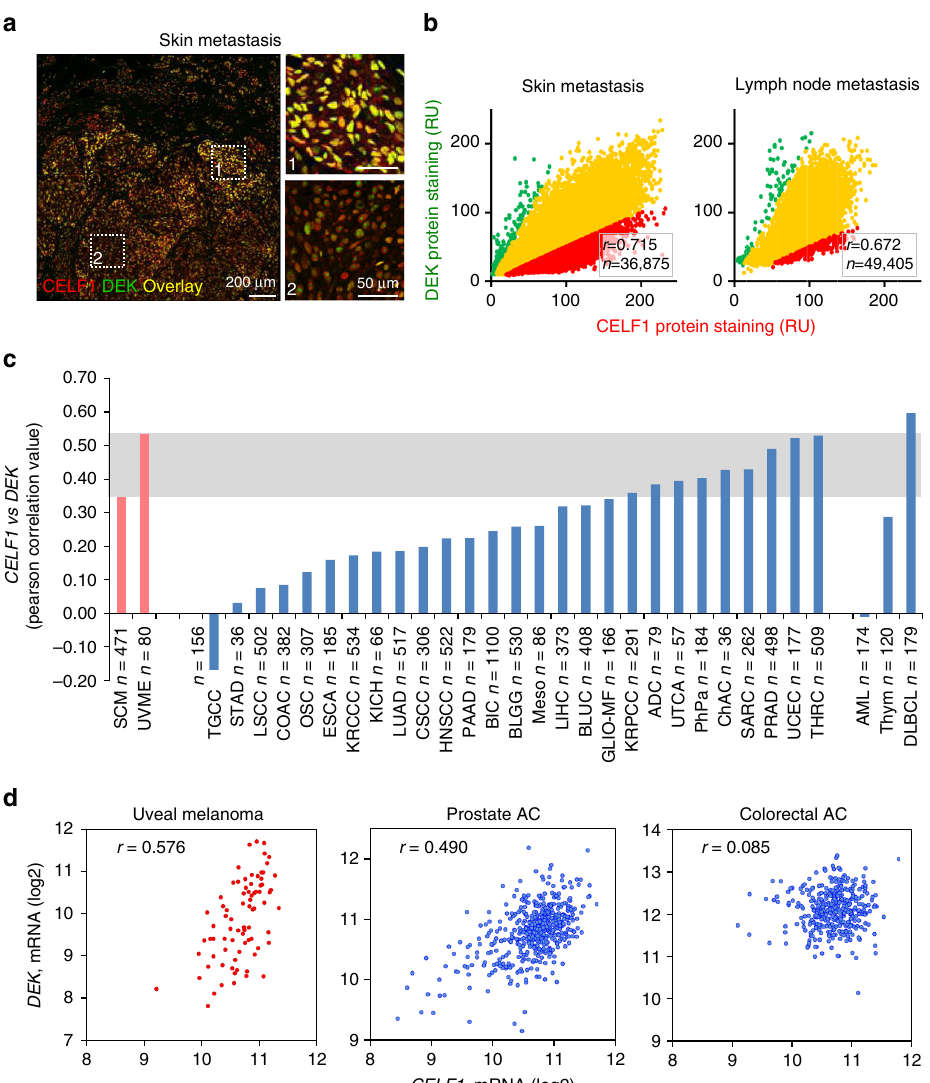
Fig. 7 DEK expression correlates with CELF1 expression in vivo. a Single-cell quanti fi cation analysis of CELF1 (red) and DEK (green) protein expression by confocal microscopy in a representative skin metastasis of human melanoma. Images on the right show higher magni fi cation of selected areas of the lesion with high or low expression of both proteins (insets 1 and 2, respectively). b Quanti fi cation of nuclear staining of CELF1 and DEK in skin and lymph node melanoma metastasis human biopsies, respectively. Relative nuclear staining of CELF1 and DEK plotted in a maximum range of RGB color scale (0 – 255). Data points were pseudo-colored based on red/green signal intensity ratio (red, ratio ≥ 2; green, ratio ≤ 0.5; yellow, 0.5 < ratio < 2). r , Pearson correlation; n , total number of quanti fi ed cells in the whole tissue. c DEK vs. CELF1 mRNA expression in various cancer types plotted as a function of corresponding signi fi cance (Pearson correlation value) ADC adrenocortical carcinoma, AML acute myeloid leukemia, BIC breast invasive carcinoma, BLGG brain lower grade glioma, BLUC bladder urothelial carcinoma, ChAC cholangiocarcinoma, COAC colorectal adenocarcinoma, CSCC cervical squamous cell carcinoma and endocervical adenocarcinoma, ESCA esophageal carcinoma, GLIO-MF glioblastoma multiforme, HNSCC head and neck squamous cell carcinoma, KICH kidney chromophobe, KRCCC kidney renal clear cell carcinoma, KRPCC kidney renal papillary cell carcinoma, LIHC liver hepatocellular carcinoma, LNDLBCL lymphoid neoplasm diffuse large B-cell lymphoma, LSCC lung squamous cell carcinoma, LUAD lung adenocarcinoma, Meso mesothelioma, OSC ovarian serous cystadenocarcinoma, PAAD pancreatic adenocarcinoma, PhPa pheochromocytoma and paraganglioma, PRAD prostate adenocarcinoma, SARC sarcoma, SCM skin cutaneous melanoma, STAD stomach adenocarcinoma, TGCC testicular germ cell cancer, THRC thyroid carcinoma, Thym thymoma, UCEC uterine corpus endometrial carcinoma, UTCA uterine carcinosarcoma, UVME uveal melanoma. n , number of samples. d DEK vs. CELF1 mRNA in uveal melanoma ( n = 80), prostate adenocarcinoma ( n = 498) and colorectal adenocarcinoma ( n = 382) patients (data obtained from TCGA) shown on correlation scatter plots Methods μ g/mL penicillin/streptomycin (Invitrogen). Cell lines have been authenticated Cell culture . The human melanoma cell lines SK-Mel-5, SK-Mel-19, SK-Mel-28, using GenePrint 10 Loci Service. Primary human melanocytes, keratinocytes, and fi broblasts were isolated from foreskins of healthy donors by differential tripsini- SK-Mel-29, SK-Mel-103, and SK-Mel-147 were initially obtained from David zation 20 . Melanocytes were cultured in Medium 254 (Invitrogen) supplemented Polsky from the Memorial Sloan Kettering cell repository. G-361 and UACC-62 with 1% melanocyte growth factors (HMGS, Invitrogen), 0.2mM CaCl 2 , and 100 were from the ATCC. WM-1366 and LU-1205 were provided by Meenhard Her- μ g/mL penicillin/streptomycin; keratinocytes were cultured in Epilife Medium lyn ’ s group at the Wistar Institute (see Supplementary Table 1 for genetic back- (Invitrogen) supplemented with 1% keratinocyte growth factors (HKGS, Invitro- grounds). These cells were cultured in Dulbecco ’ s modi fi ed Eagle ’ s medium gen), 0.2 mM CaCl 2 and 100 μ g/mL penicillin/streptomycin and fi broblasts were (DMEM, Lonza) supplemented with 10% fetal bovine serum (FBS, Lonza) and 100 NATURE COMMUNICATIONS | 8: 2249 | DOI: 10.1038/s41467-017-02353-y |